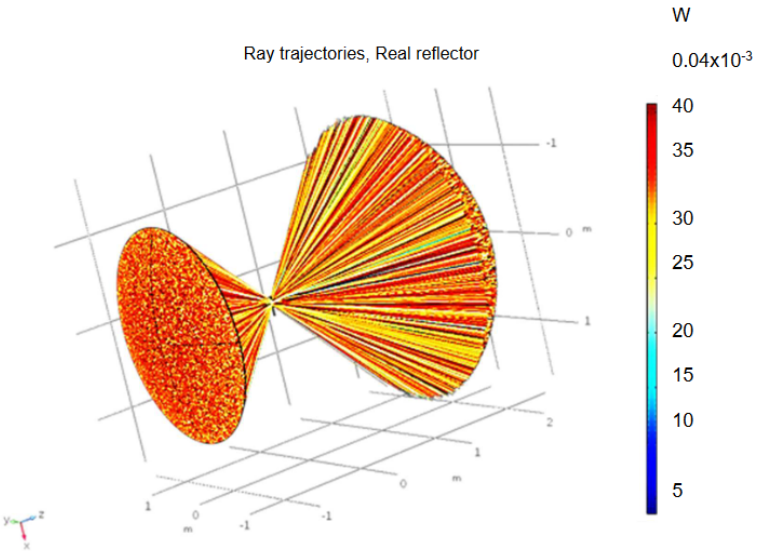
Figure 11. Trajectories of rays reflected by a real reflector and focused onto the receiver. Surface roughness, solar limb darkening and absorption were considered.